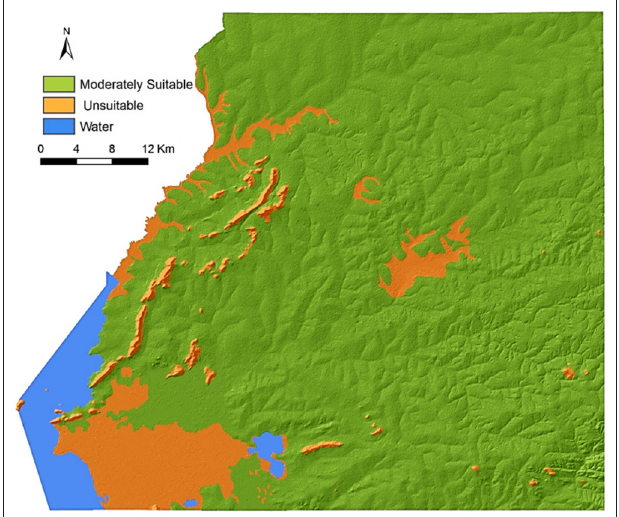
FIGURE 9 | Maize ( Zea mays L.) crop suitability map for the Busia area.